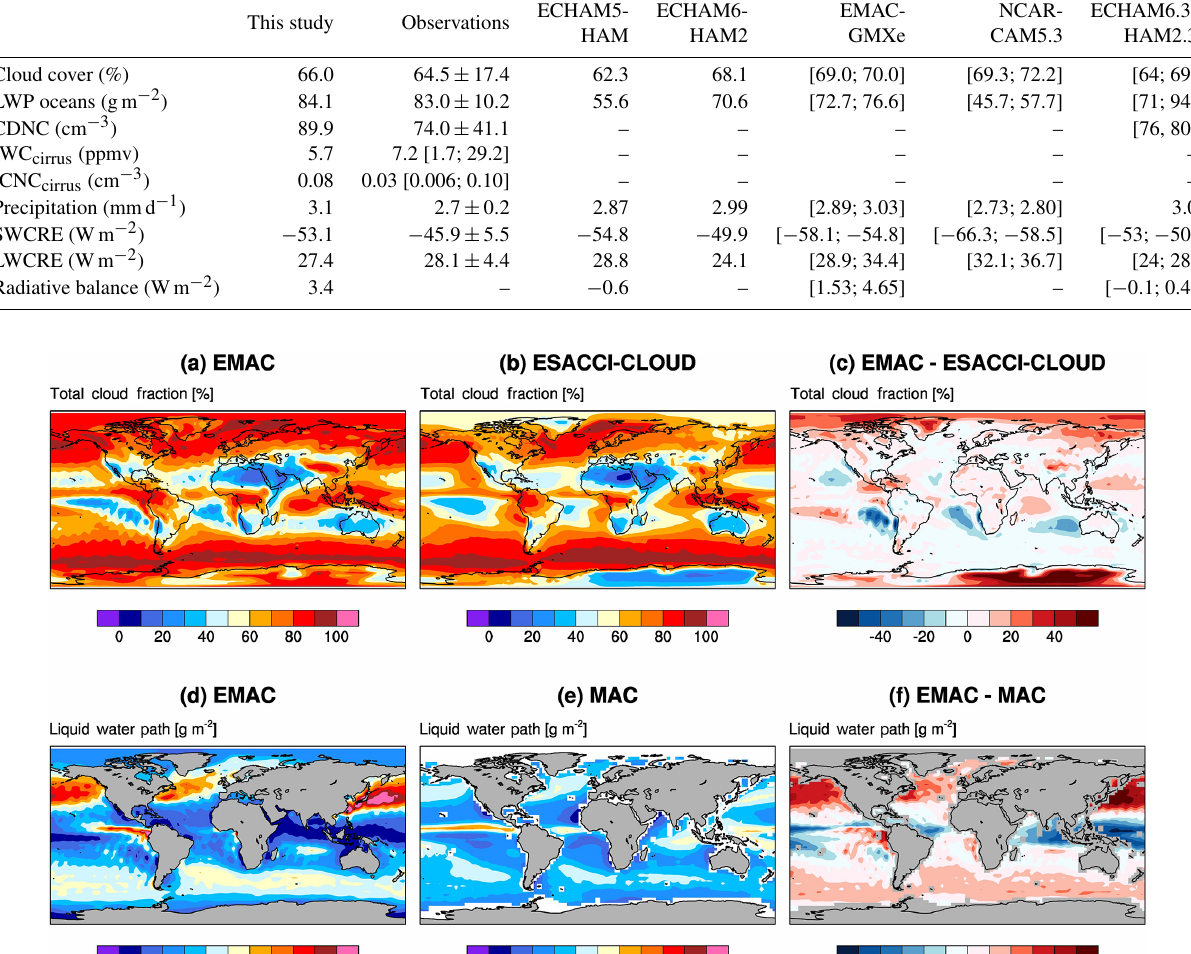
Table 3. Summary of the globally averaged cloud and radiation variables obtained with the reference set of tuning parameters ( γ r = 5, γ s = 1300, CDNC min = 20cm − 3 , and d nuc = 10nm), compared with the observations summarized in Table 2 and with the results of other